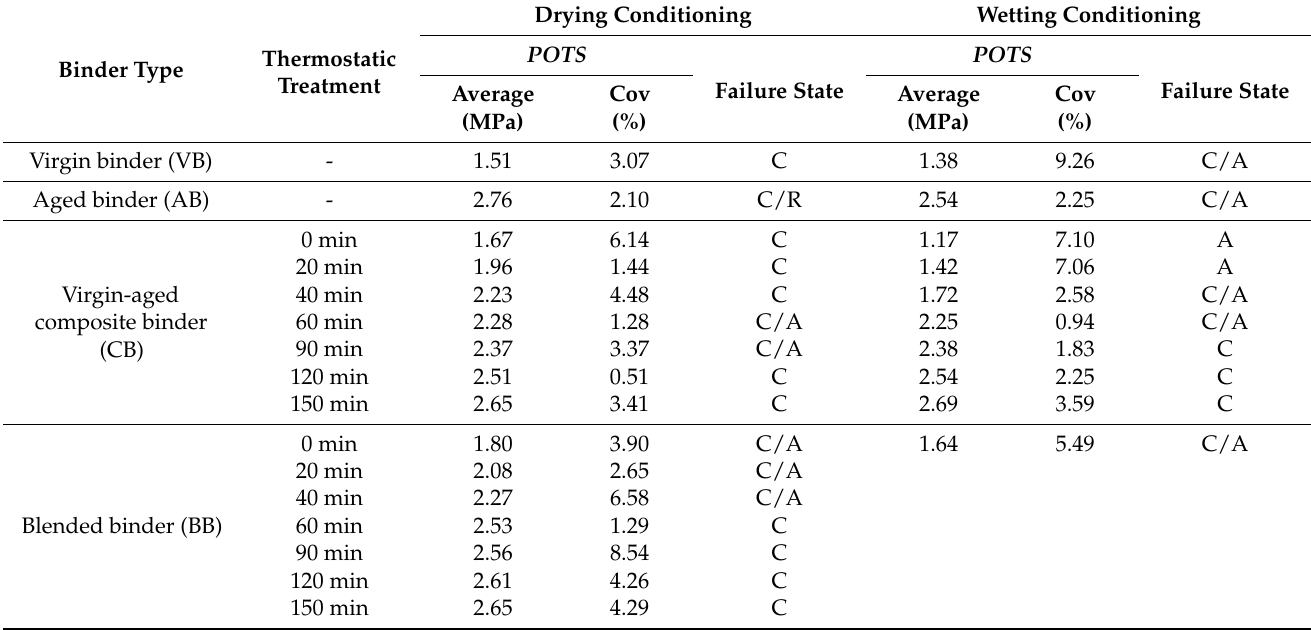
Table 4. Summarized results from pull-off